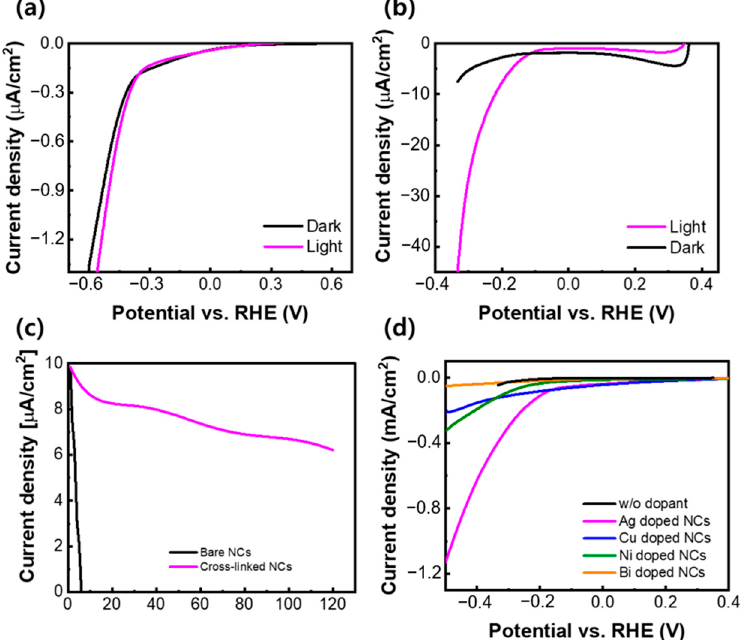
Figure 6. ( a , b ) Photoelectrochemical HER performance of core-shell CsPbBr 3 /SiO 2 NCs ( a ) with sole APTES system and ( b ) with APTES/vinyltrimethoxysilane. ( c ) Stability test of CsPbBr 3 /SiO 2 NCs with sole APTES system and with APTES/vinyltrimethoxysilane. ( d ) J-V curve under 1 Sun for four different core-shell CsPbBr 3 /SiO 2 NCs with APTES/vinyltrimethoxysilane.